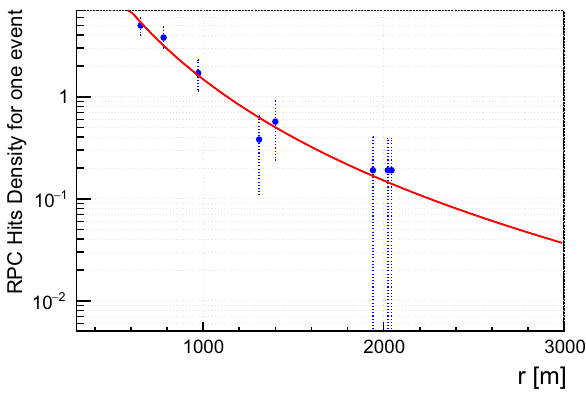
Fig. 7 LDF of one QGSJET-II.04 proton shower with E = 10 19 . 8 eV and θ = 38 ◦ . RPC hits densitiy are given in square meters